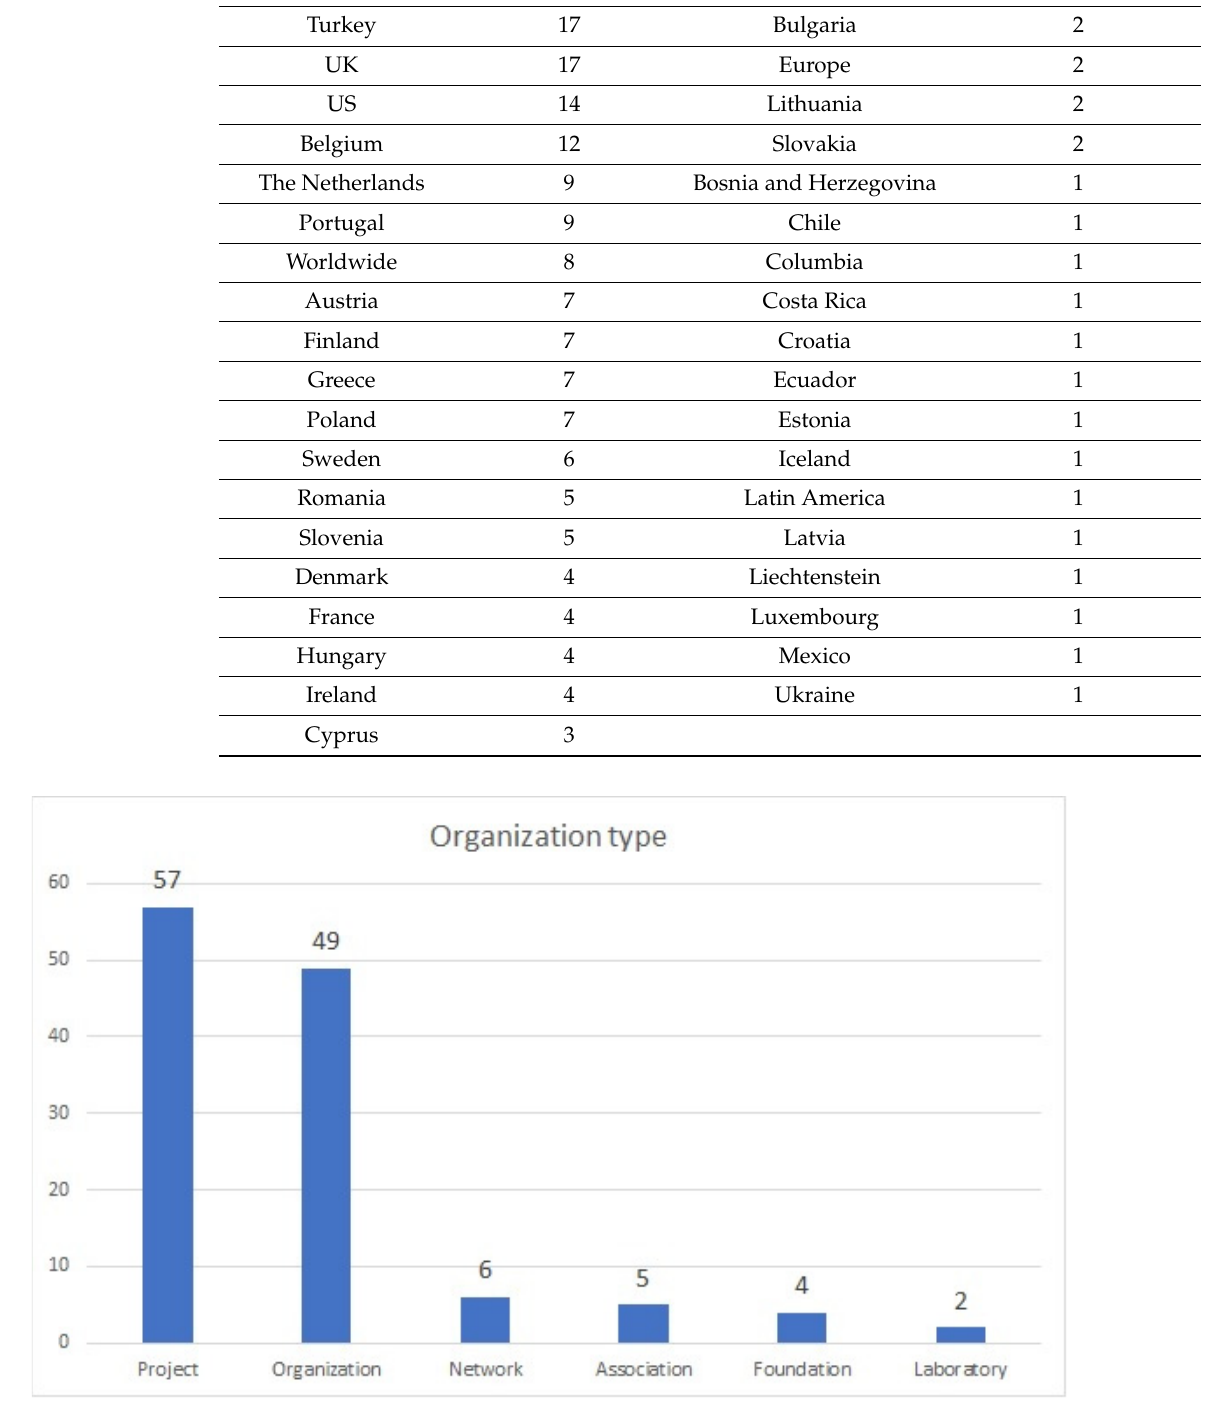
Figure 2. Initiative organization type.